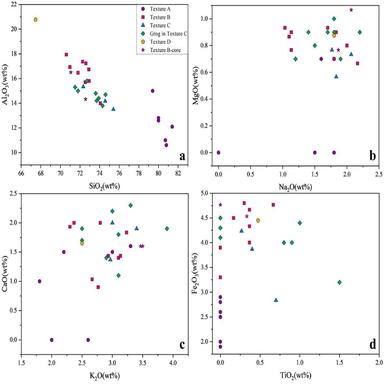
Binary plots of the chemical concentration of four mould textures and one core texture. a): SiO2 against Al2O3; b): Na2O against MgO; c): K2O against CaO; d): TiO2 against Fe2O3.